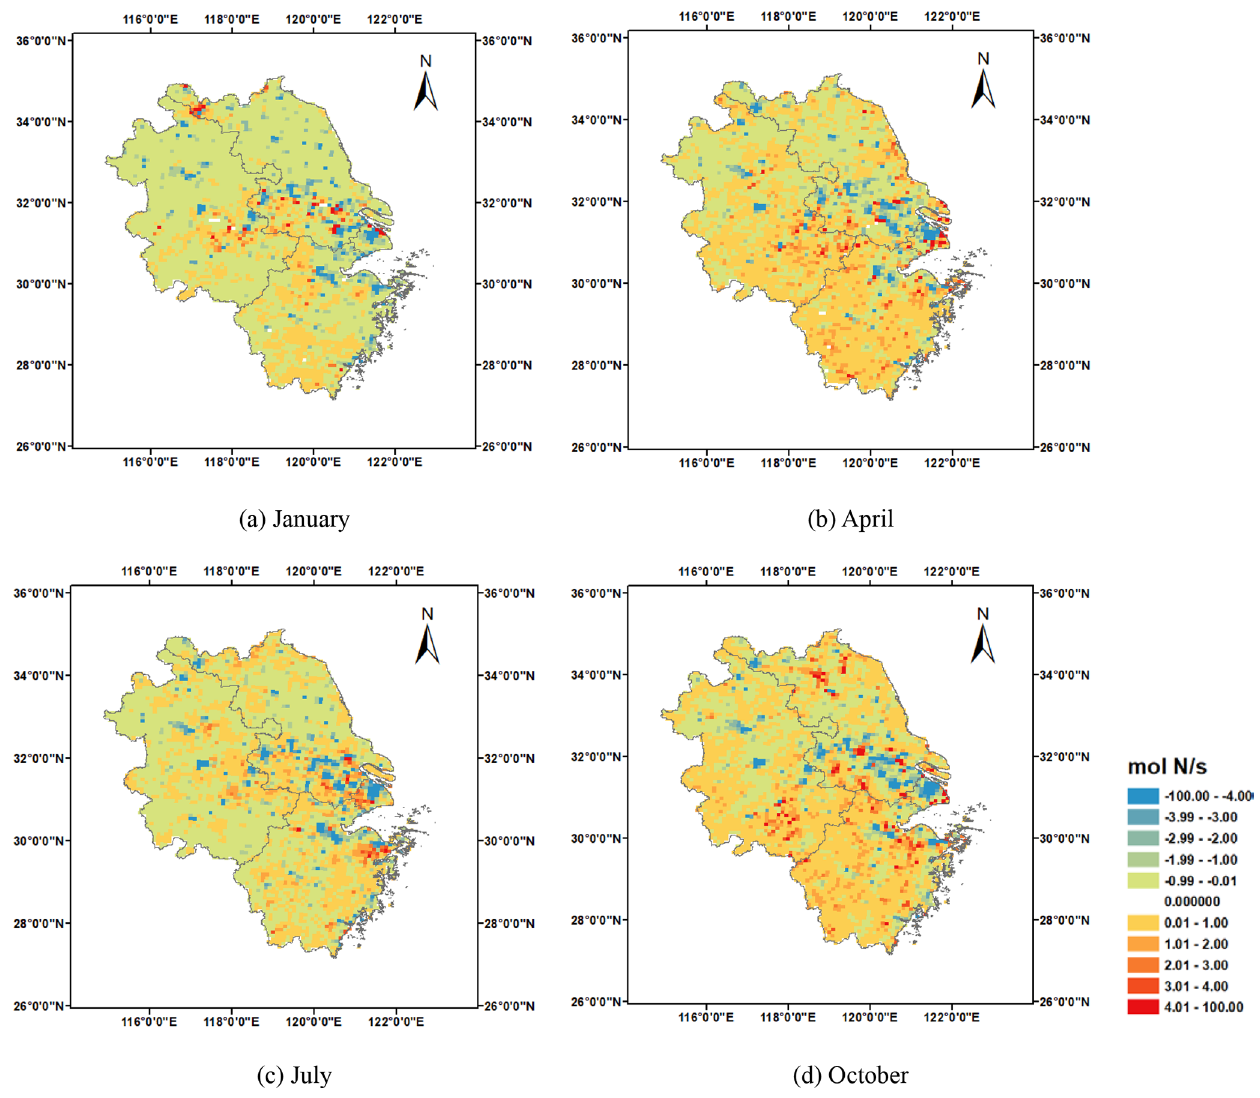
Figure 3. The spatial differences between the bottom-up and top-down estimates of NO x emissions for January, April, July, and October 2016 (top-down minus bottom-up, in units of